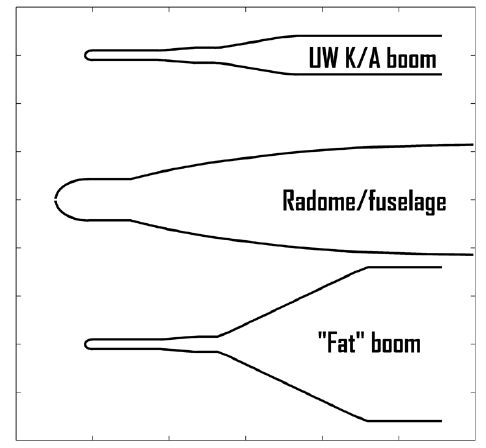
Fig. 6. Models of aircraft and boom configurations (see text).